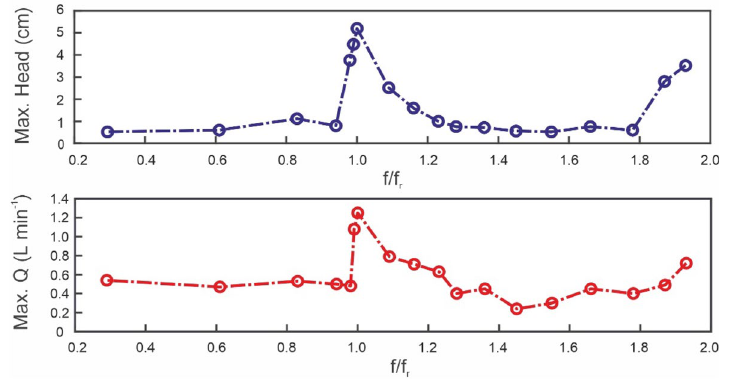
Figure 8. Maximum head and maximum net flowrate frequency